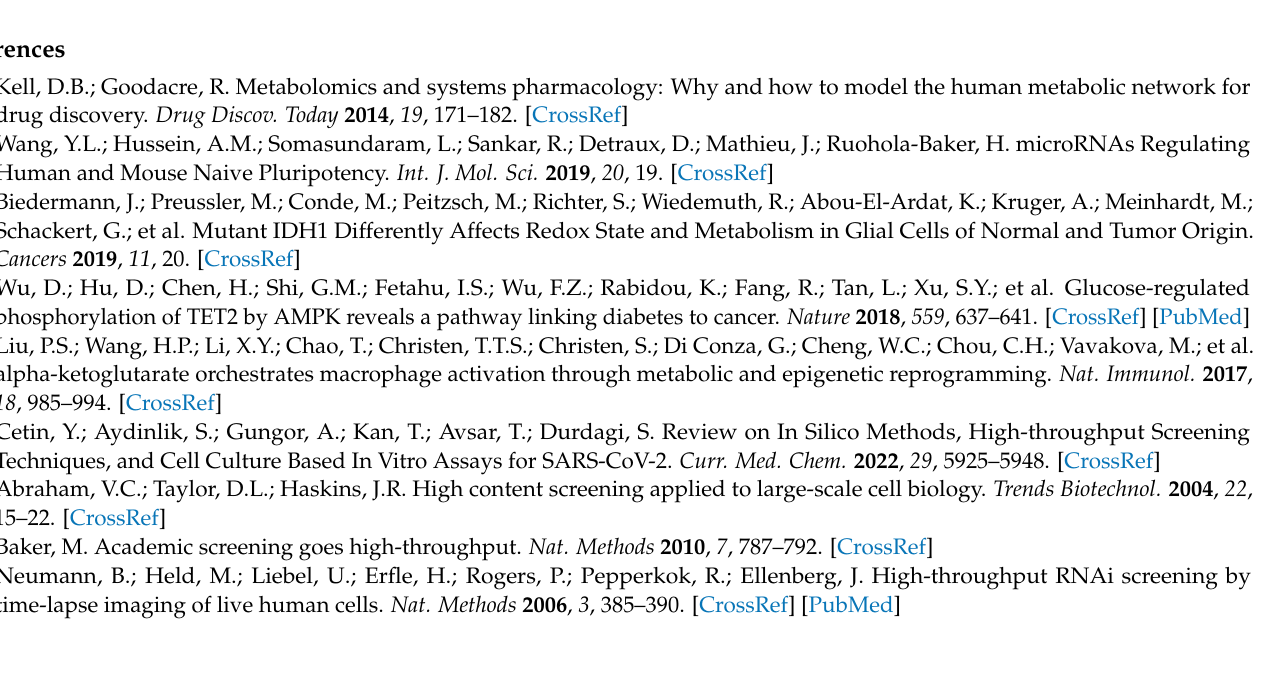
coumarin derivatives and a control group; Figure S3: PCA scores plots of relative concentrations of metabolites data from each coumarin derivative compared with control group; Figure S4: Result of HCA of relative concentrations of metabolites data from twelve coumarin derivatives and a control group; Figure S5: PLS-DA scores plots of relative concentrations of metabolites data from each coumarin derivative compared with control group; Figure S6: Corresponding permutation tests of PLS-DA models of relative concentrations of metabolites data from each coumarin derivative compared with control group; Figure S7: OPLS-DA scores plots of relative concentrations of metabo- lites data from each coumarin derivative compared with control group; Table S1: The IC 50 value of coumarin derivatives in the U251 cells; Table S2: Detailed information of twelve coumarin derivatives in our work; Table S3: The tagged chemical shifts (ppm) and function groups from the indicated metabolites; Table S4: Detailed statistical information for each group of differential metabolites; Table S5: The results of significantly disturbed metabolic pathways for each coumarin derivative affecting the cellular U251metabolic